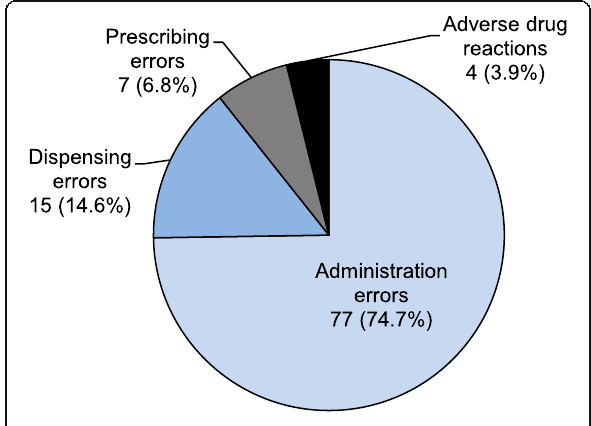
Fig. 4 Medication errors (administration, dispensing, and prescribing) and adverse drug reactions in the Kampo medicine-related incidents